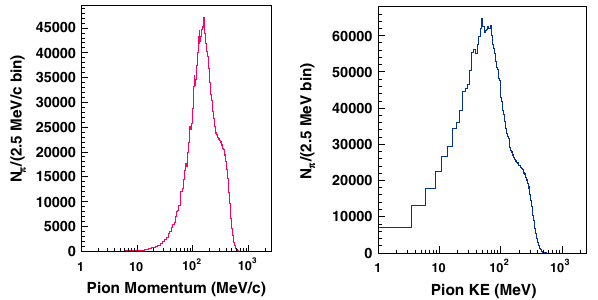
FIG. 8. Pion momentum and energy spectra for incident proton energy of 750 MeV.